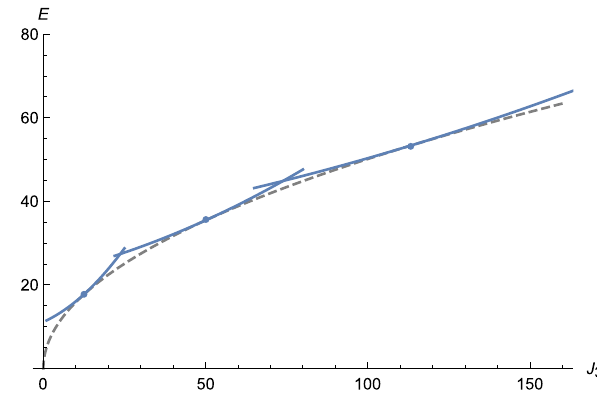
Fig. 1 Energy vs. angular momentum for vortons in the case of large λ ; specifically we used here T = 1, v = 1 and we plot the values (43) for three cases m = 1 , 2 , 3. The dashed line correspond to the Regge trajectory while the dots correspond to the optimal values when s = v